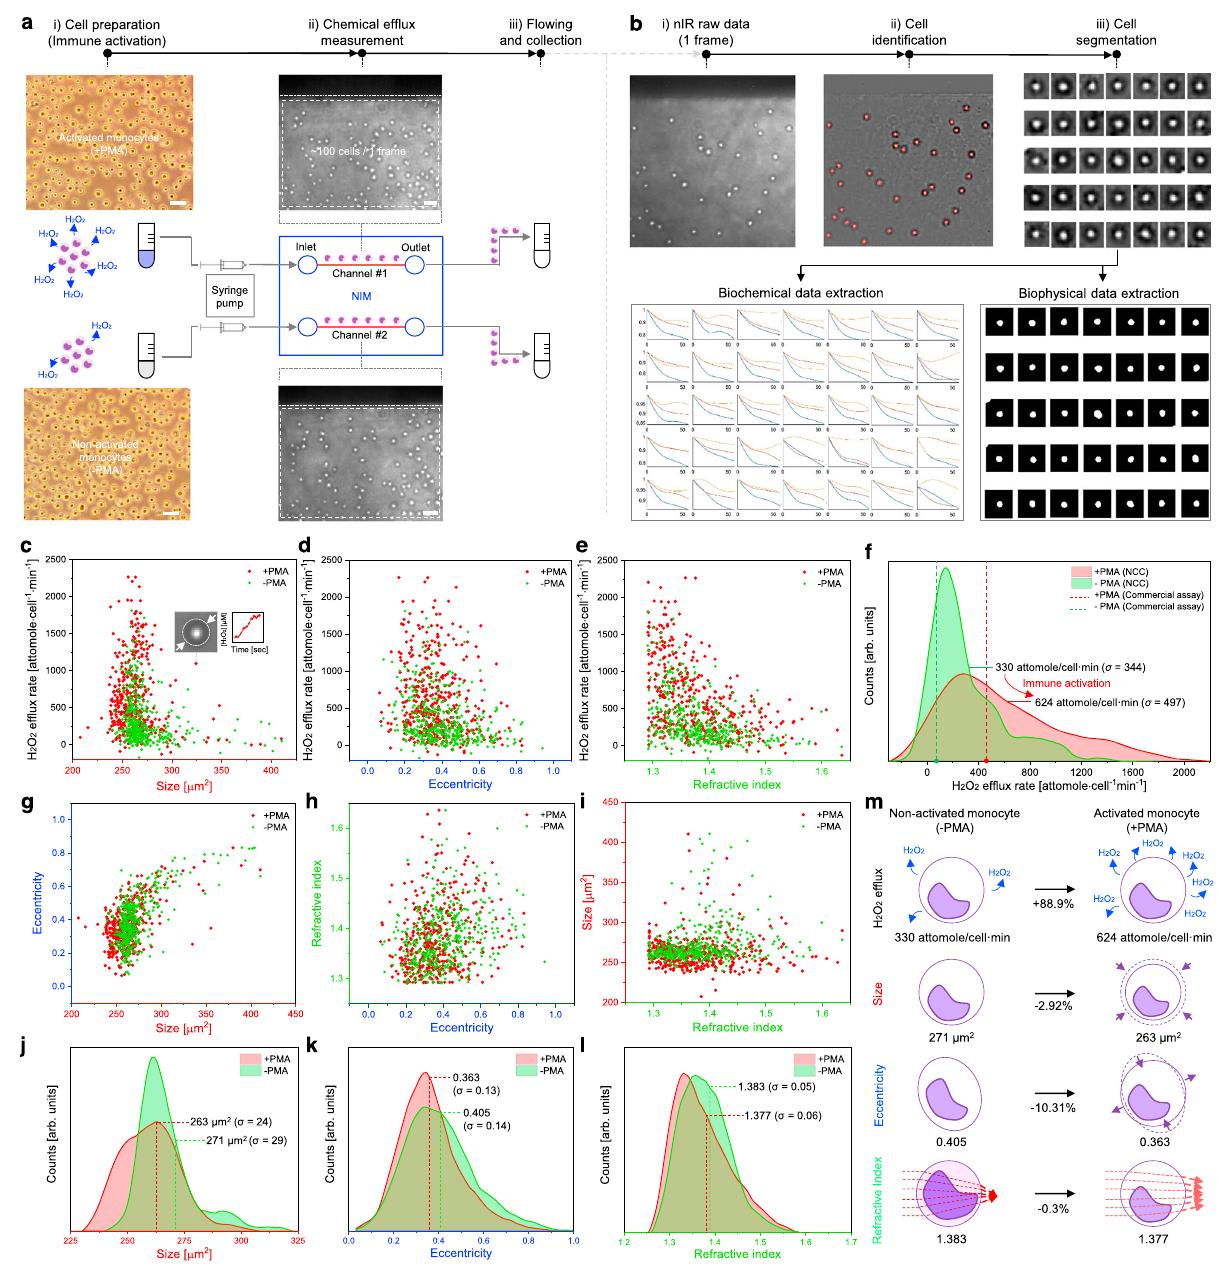
Fig. 5 NCC for monitoring of multimodal immune response heterogeneities. a Schematics and nIR images of NCC set up with distinct activation of human monocytes ( − PMA and + PMA). b Automatic nIR image analysis using computational code for cell data extractions. c – e NCC cytometry plots of H 2 O 2 ef fl ux rate vs. biophysical parameters (( c ) size (2D projected area), ( d ) eccentricity, ( e ) RI) of two monocytes populations. Data are n cell = 413 for − PMA, n = 414 for + PMA from n = 6 biologically independent samples. f NCC distribution curves of H cell NCC cytometry plots for cell biophysical parameters (( g ) eccentricity vs. size, ( h ) RI vs. eccentricity, ( i ) size vs RI). j – l NCC distribution curves of each biophysical parameters (( j ) size, ( k ) eccentricity, ( l ) RI). m Schematics illustrations for cell properties variations of human monocyte populations with immune activations. Scale bars: 20 µ